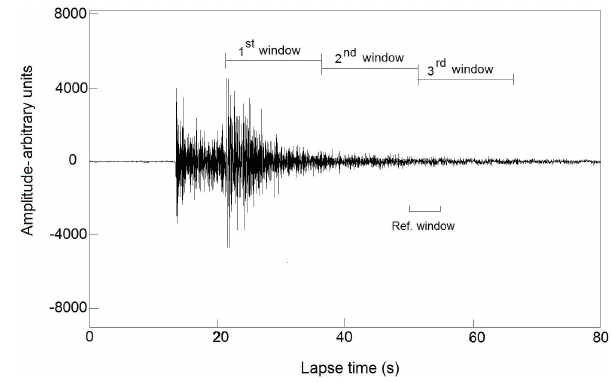
Fig. 3. Seismogram of an event (200404271343264.JS) in Liyang region. The three consecutive time windows and the reference time window are displayed by the horizontal